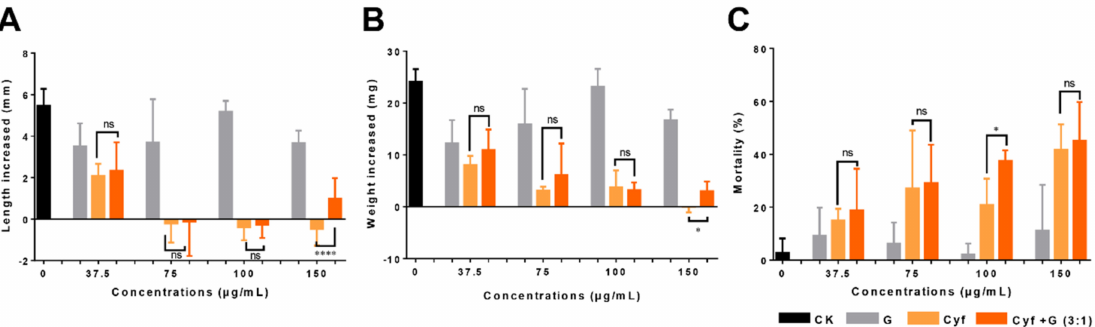
Figure 7. Insecticidal activity of different concentrations of graphene, Cyf, and Cyf/G against cotton bollworm. ( A ) Body length change, ( B ) weight change, and ( C ) mortality of the cotton bollworm. Note: statistically significant differences ( α = 0.05 and 0.0001 levels) of values are indicated with “*” and “****”, respectively. “ns”: not